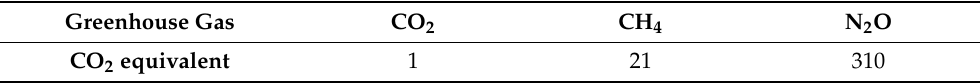
Table 6. Global warming